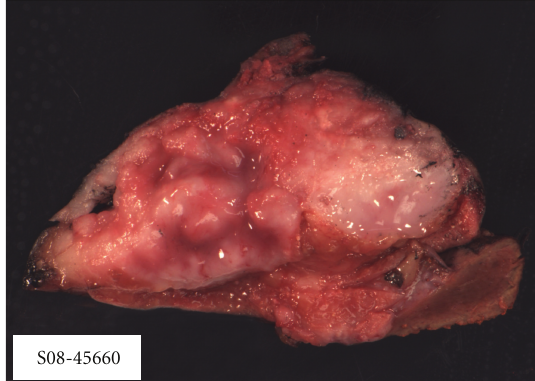
Figure 4: In the higher magnification, nuclear moldings with many abnormal mitosis, apoptotic cells, and necrosis are seen. (HE) ×